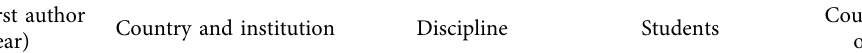
Table 3: Summary of grand challenge